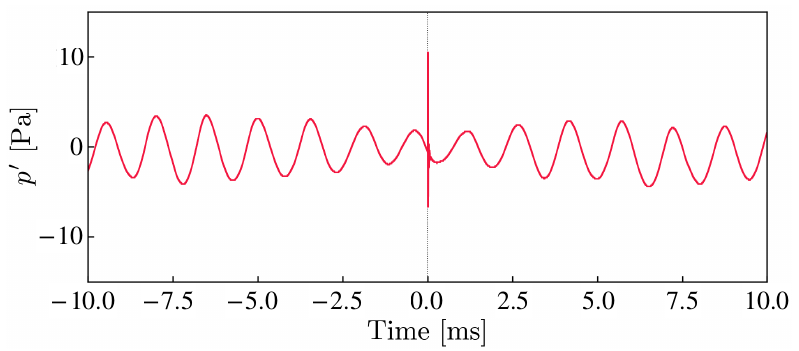
Figure 8. Pressure fluctuations p (cid:48) measured at x = 125 mm (50% chord position) on the pressure side surface.